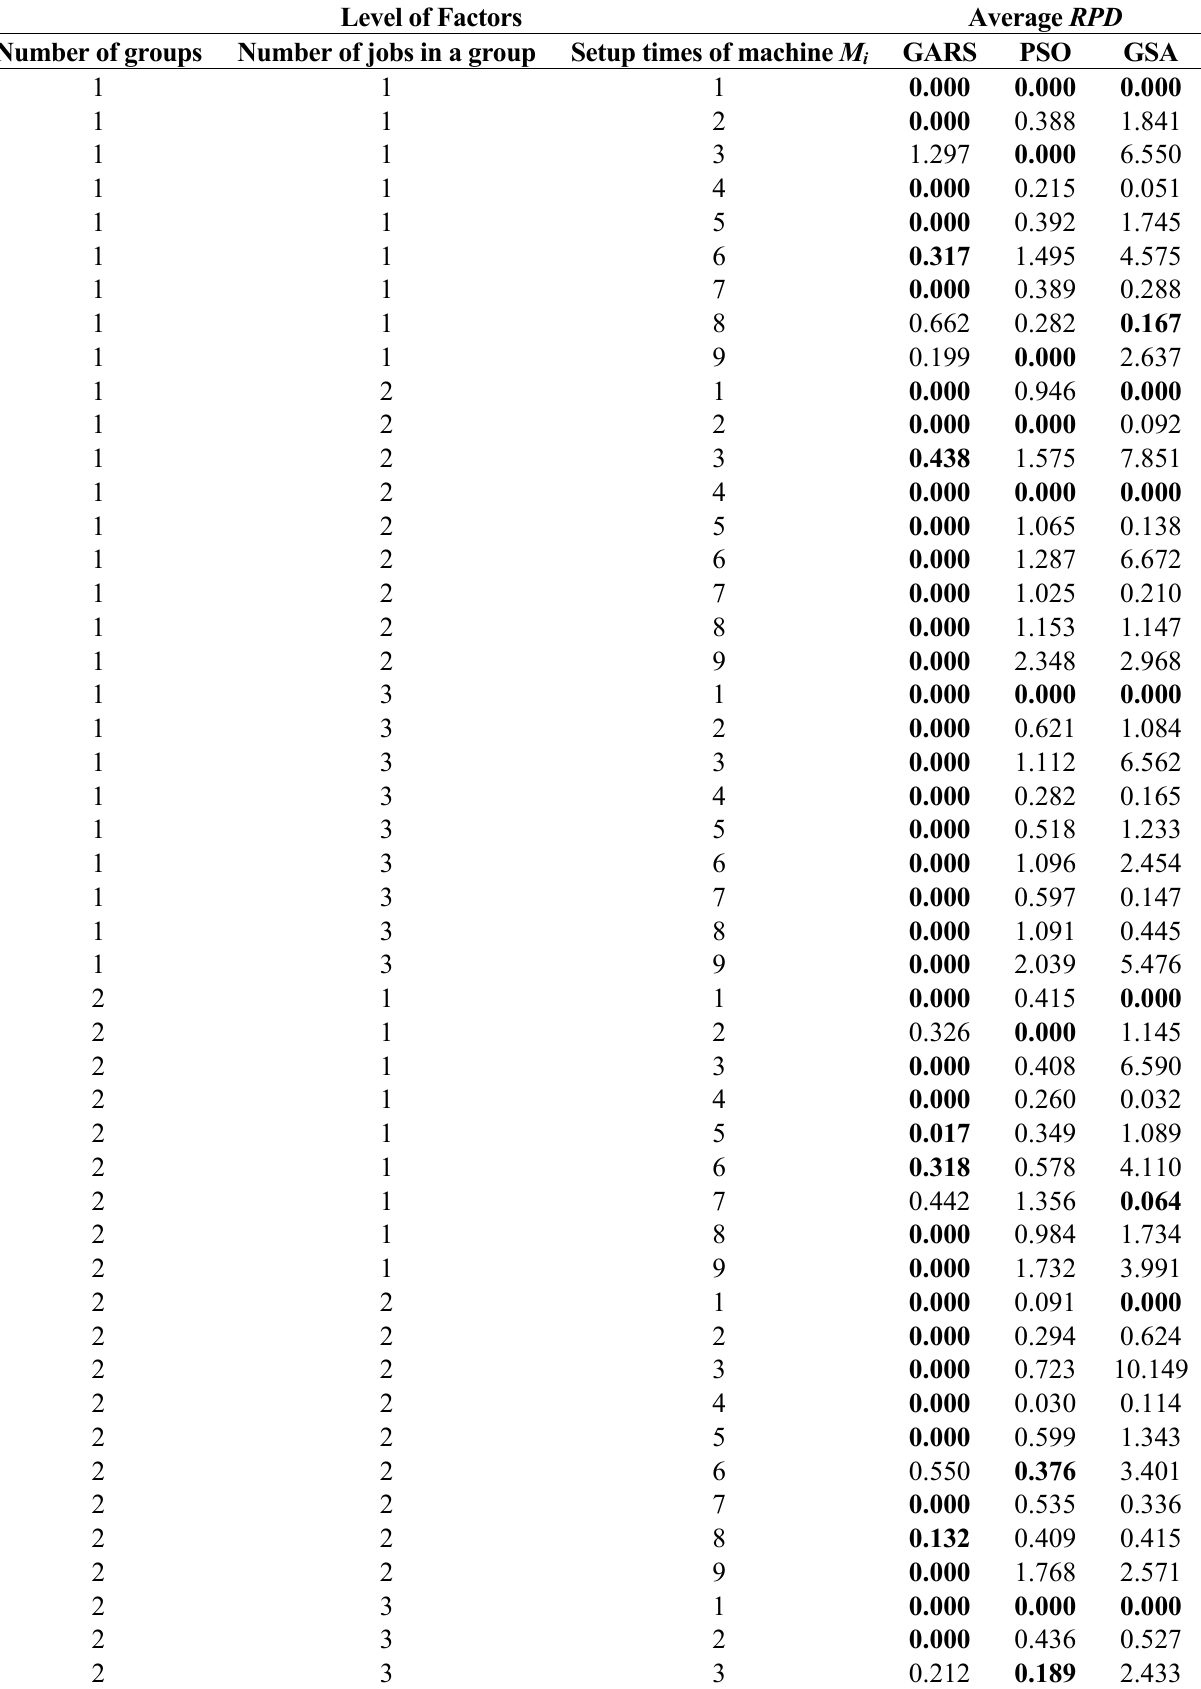
Table 8. Average RPD values for three-machine